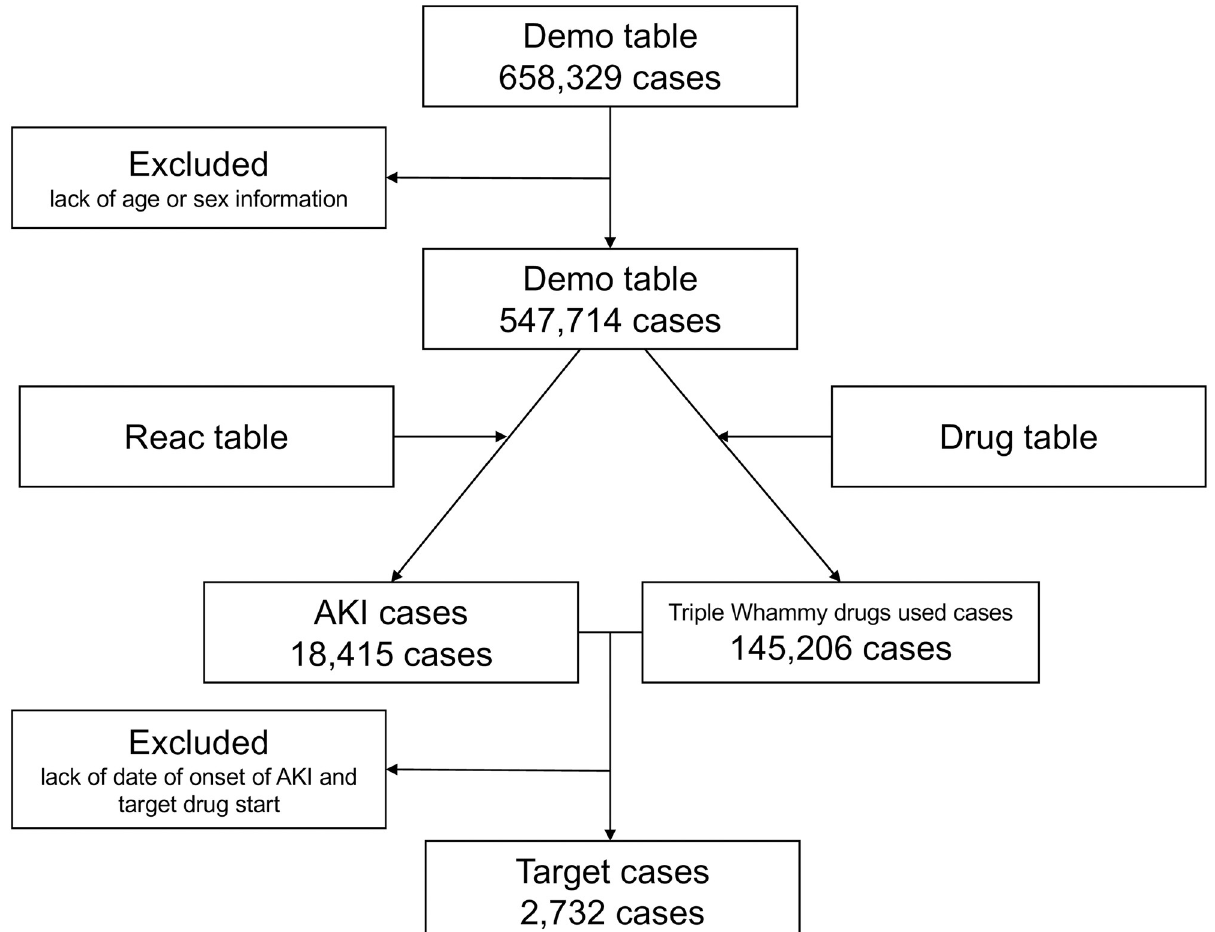
Fig 1. Flow chart of case inclusion and exclusion from the JADER database. AKI, acute kidney injury.